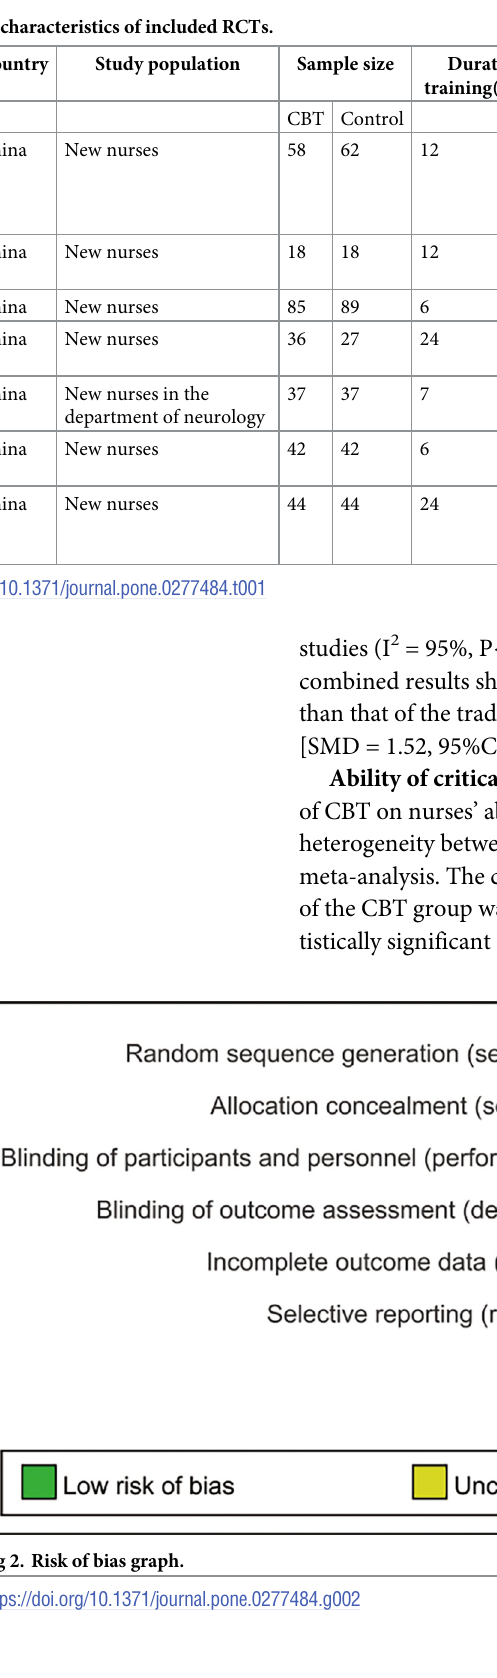
Table 1. The characteristics of included RCTs.